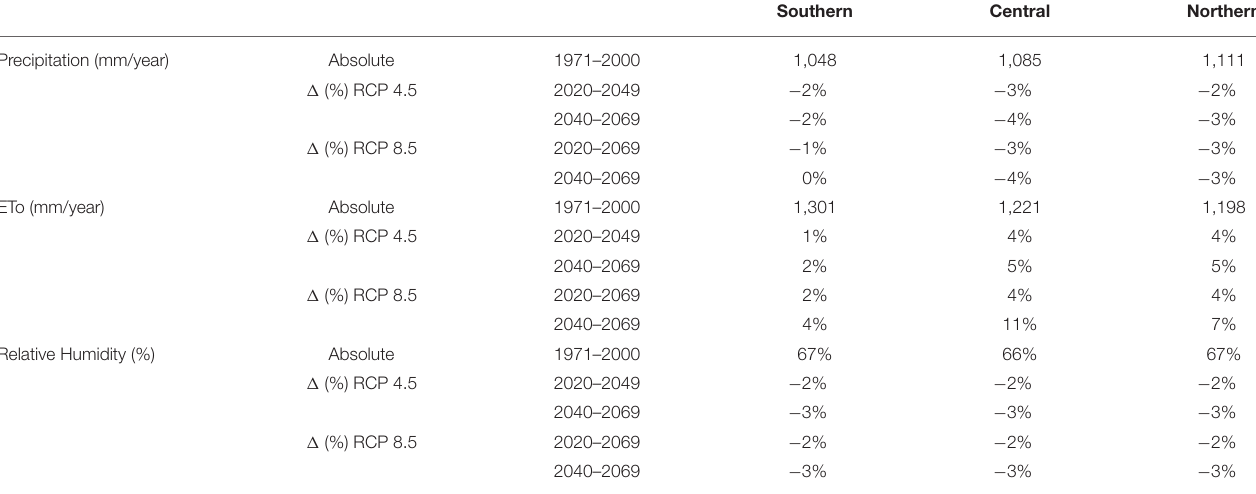
TABLE 2 | The historic precipitation rate, reference evapotranspiration rate (ETo) and relative humidity in the three regions of Malawi for the 1971–2000 period, and the Regional Climate Model (RCM) ensemble mean or calculated projected change ( 1 ) in these variables for the 2035 (2020–2049) and 2055 (2040–2069) climate periods under the Representative Concentration Pathway (RCP) 4.5 and 8.5